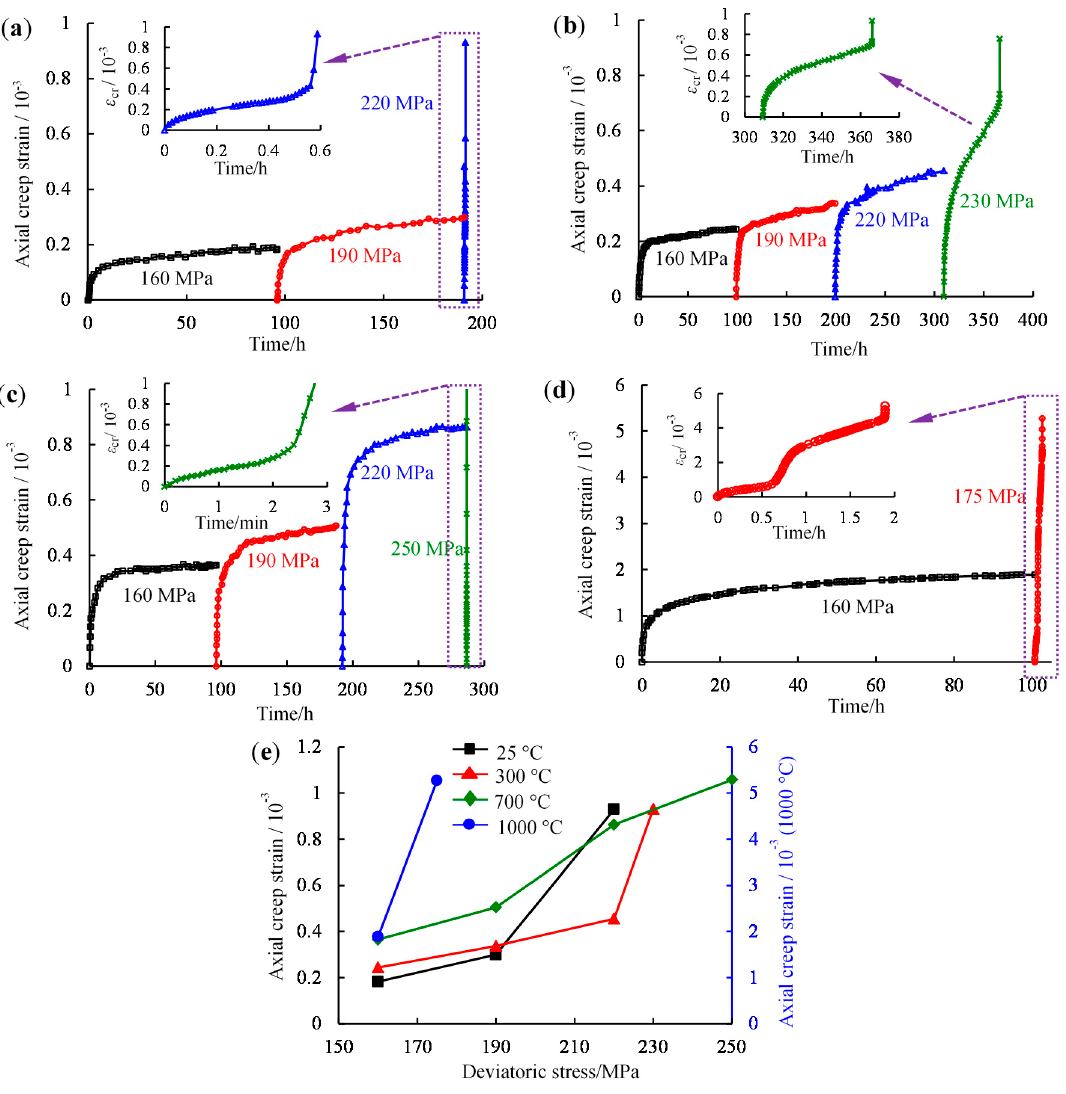
Figure 3. Axial creep strain-time curves under step-loading with σ 3 of 25 MPa at different temperatures: ( a ) 25 °C; ( b ) 300 °C; ( c ) 700 °C; ( d ) 1000 °C; ( e ) Relationship between axial creep strain and deviatoric stress.